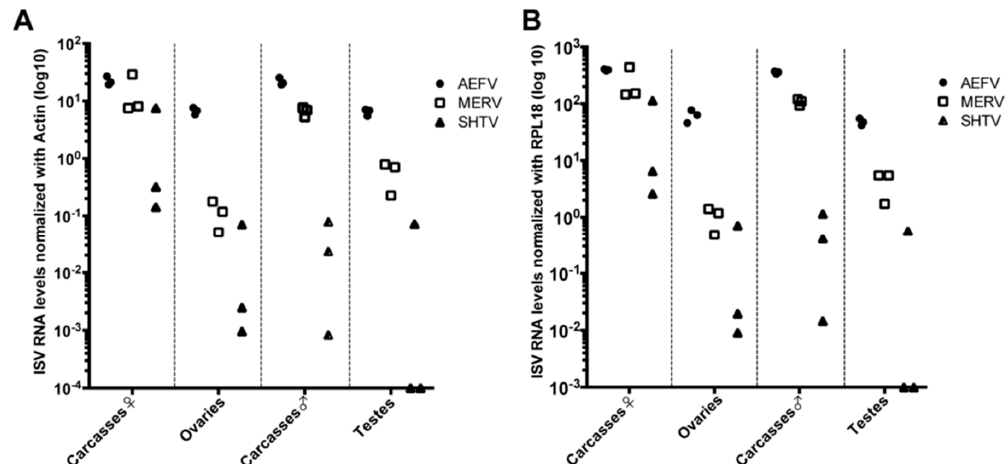
Figure 1. AEFV, MERV and SHTV infections in reproductive tissues (ovaries and testes) and carcasses. Ae. albopictus adult females and males were intrathoracically injected with an AEFV/MERV/SHTV mixture and collected at 8 days post-injection. RNA levels for each ISV in the co-infected mosquito ovaries, testes or carcasses were quantified by RT-qPCR normalized with actin (A) or RPL18 RNA (B). Each dot represents a pool of 20 reproductive tissues or carcasses.